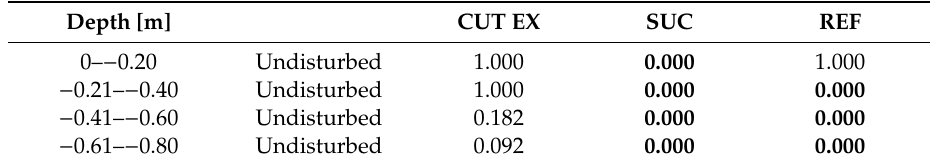
Table 18. Pairwise Kruskal–Wallis test, comparing disturbed and aggregated undisturbed areas. Significantly di ff erent areas ( p < 0.05) are indicated